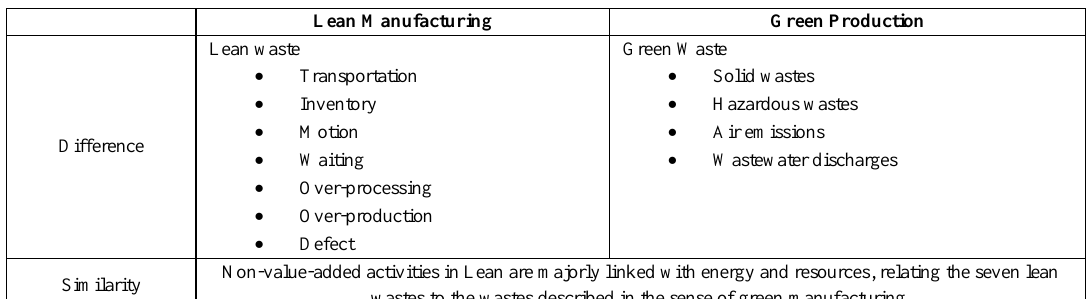
Table 1. Definition of lean manufacturing and green production, with focus on types of waste reduction and/or elimination (Abualfaraa et al., 2020; Johansson and Winroth, 2009; Kurdve and Bellgran, 2021).